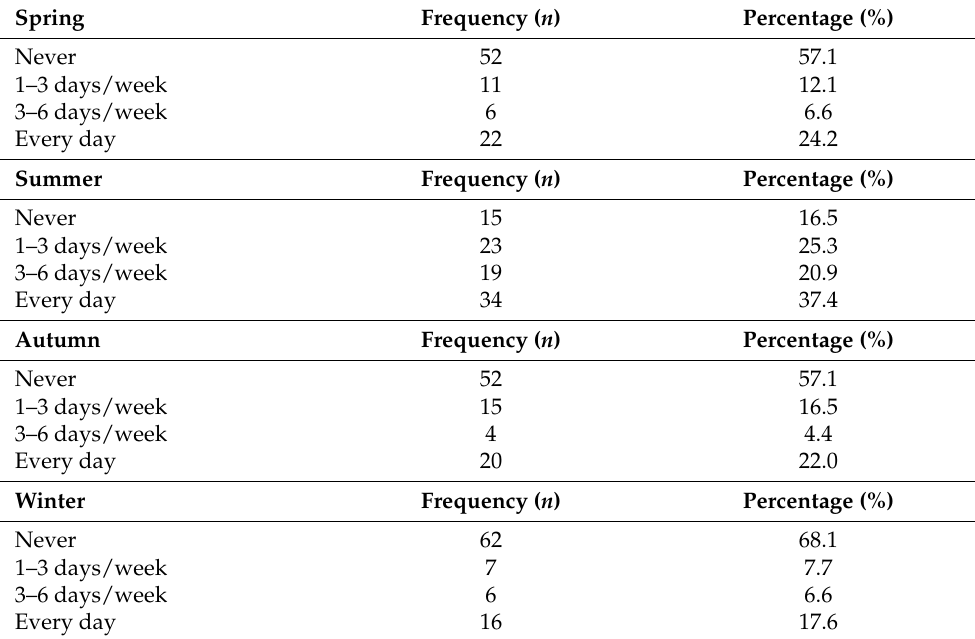
Table 6. Avoidance of going outdoors during “sunny hours” (from 12:00 p.m. to 4:00 p.m.).